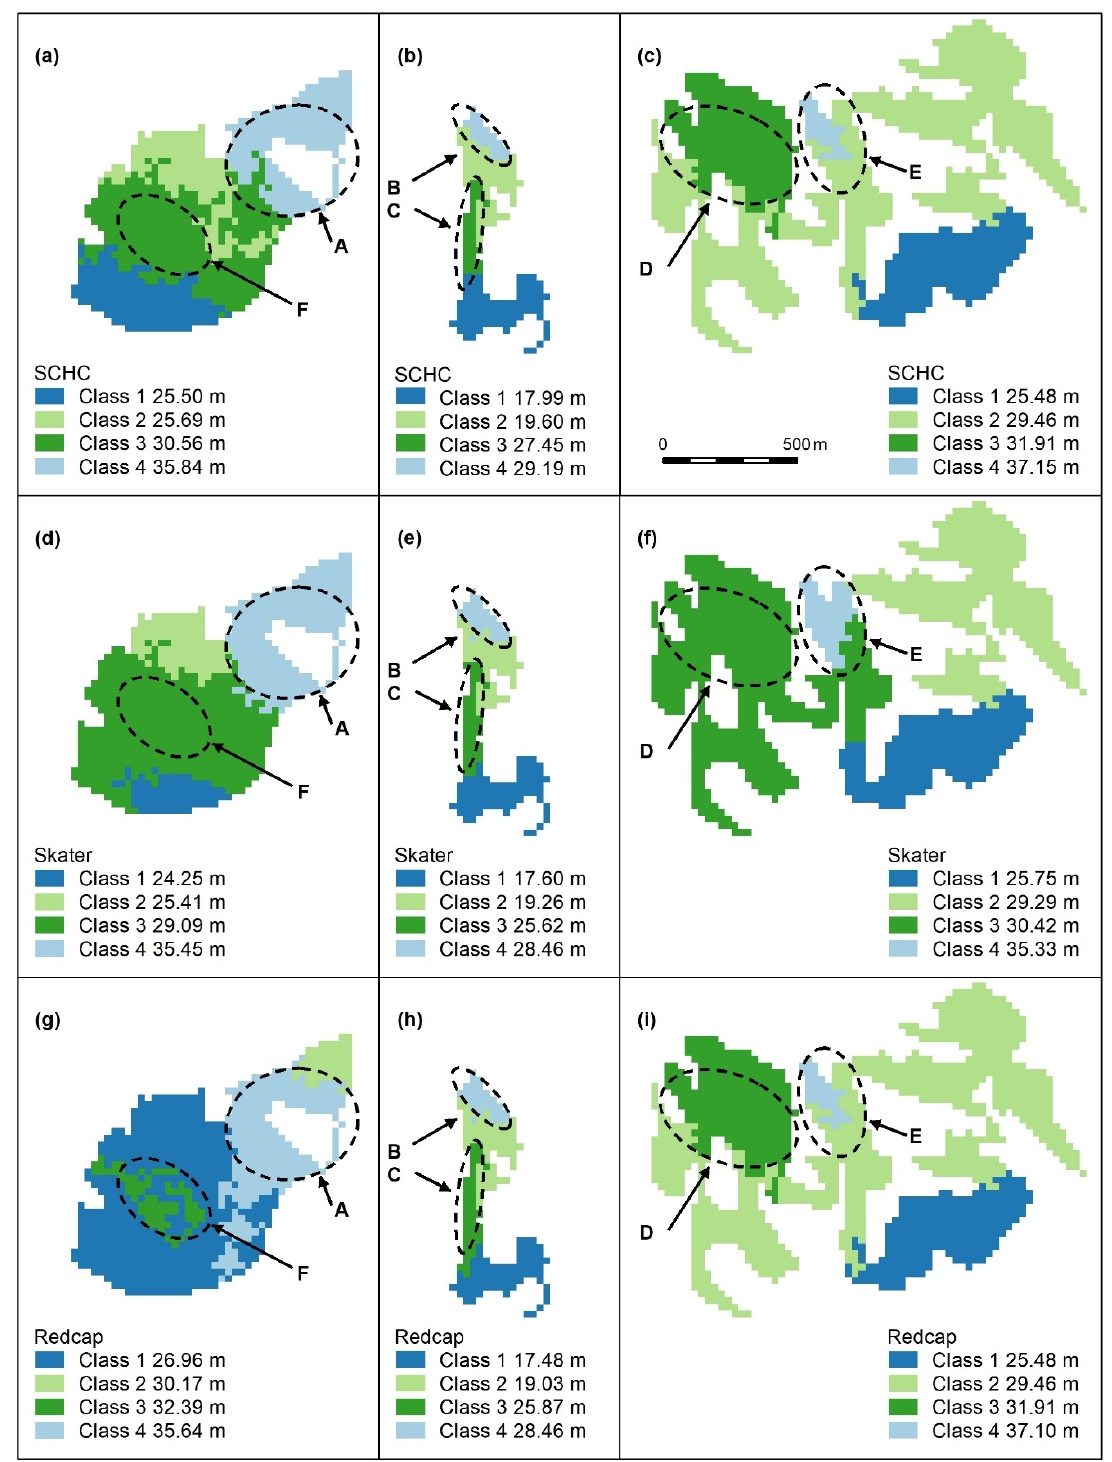
Figure A10. Spatially constrained hierarchical (SCHC, a – c ), Skater ( d – f ), and Redcap ( g – i ) clustering maps with 4 classes. Letters A–F indicate areas of higher canopy. Redcap ( g ) separates an area of regrowth forest on land previously used for farming (A, dark blue) adjoining a relatively undisturbed national park (light blue). Redcap also recognises F, the unmapped area of Eucalyptus tereticornis (dark green), which is slightly lower in height than the national park canopy but higher than the surrounding forest (dark blue). All algorithms portray C ( b , e , h ) as slightly lower than B, but the areal extent of D is exaggerated by Skater ( i ). Skater is the algorithm that best captures the areal extent of E ( i ). Panel scores: Hierarchical clustering = 14, Skater = 15, and Redcap = 16.